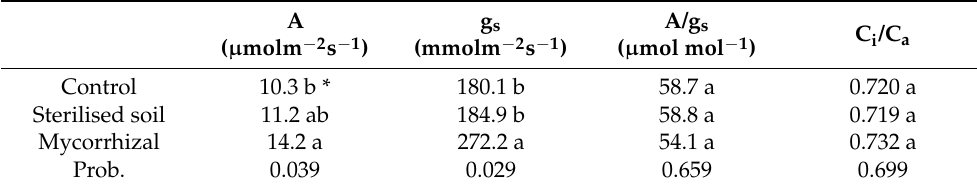
Table 4. Net photosynthetic rate (A), stomatal conductance to water vapor (g s ), intrinsic water use efficiency (A/g s ), and ratio of intercellular to atmospheric CO 2 concentration (C i /C a ) as a function of soil treatments.